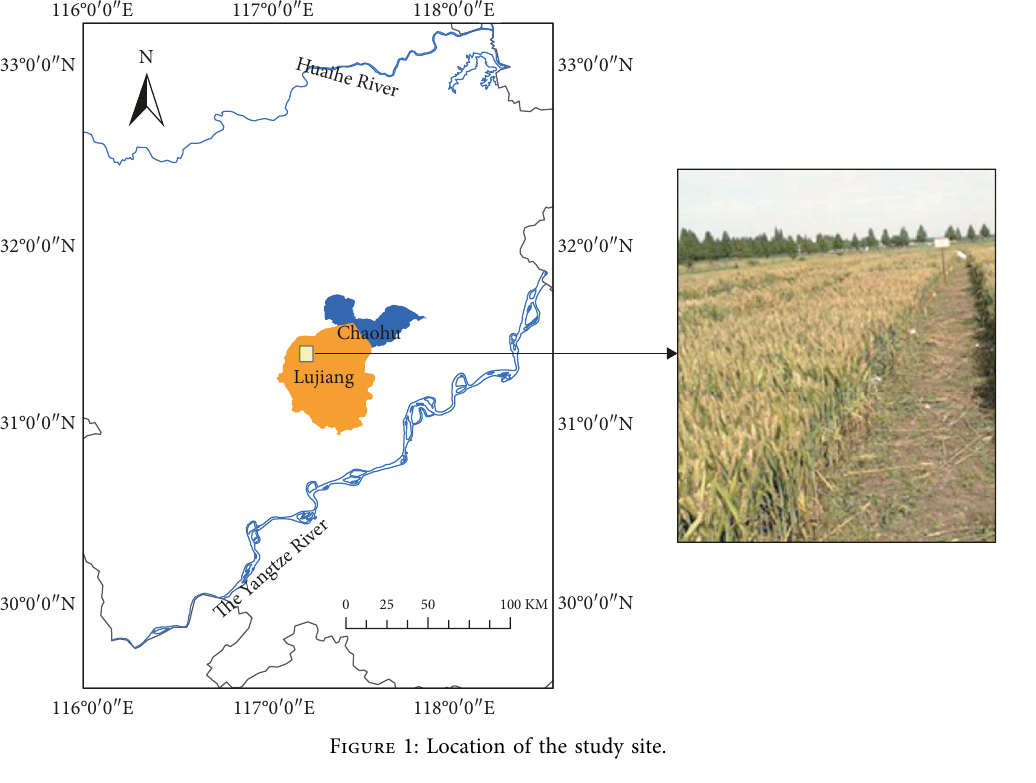
Figure 1: Location of the study site.